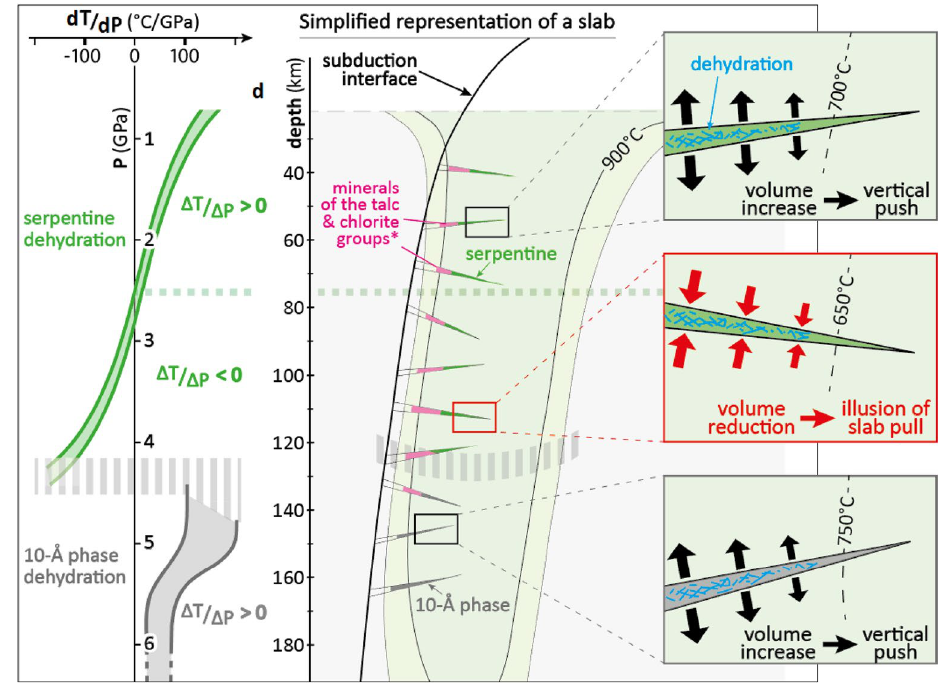
Figure 4. Stress field evolution with volume change of dehydration reactions within the slab. ( a ) Depth evolution of the inverse Clapeyron slope for the main mineral dehydrations related to the Vrancea seismicity 9 ; ( b ) expected distribution of the serpentinized faults 17 within the slab. Positive or negative Clapeyron slopes imply positive or negative total volume changes (solid + fluid), respectively, which impacts the stress field within the surrounding peridotites, as reflected by the focal mechanisms of earthquakes occurring within the